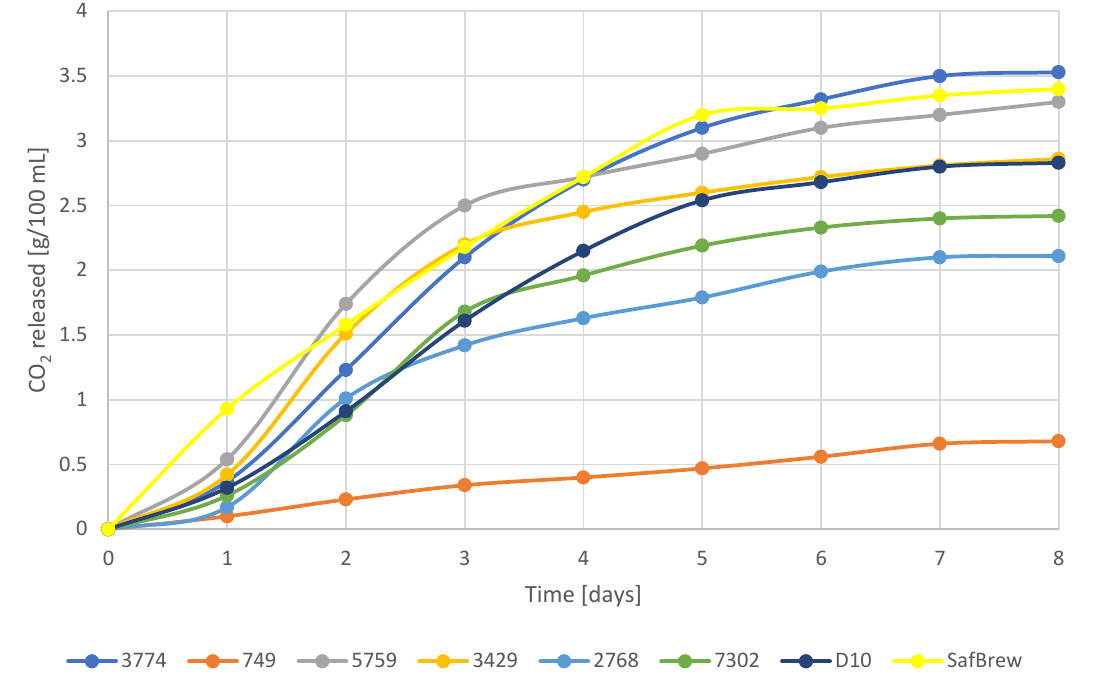
Figure 1. The kinetics of beer fermentation with different yeast strains; Saccharomyces paradoxus (7302), Saccharomyces kudriavzevii (3774), Wickehamomyces anomalus (5759), Hanseniaspora uvarum (2768), Dekkera bruxellensis (3429), Zygosaccharomyces bailii (749), Torulospora delbrueckii (D10), Saccharomyces cerevisiae Safbrew T-58 (Safbrew). Table 1. The main parameters of beer produced by non-conventional yeasts.